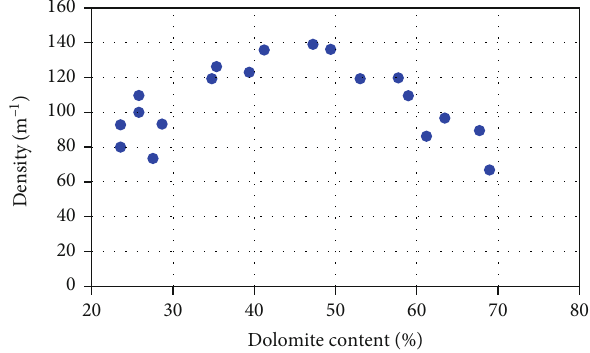
Figure 8: Relationship between density of lamellation fractures and dolomite content in the Qianjiang